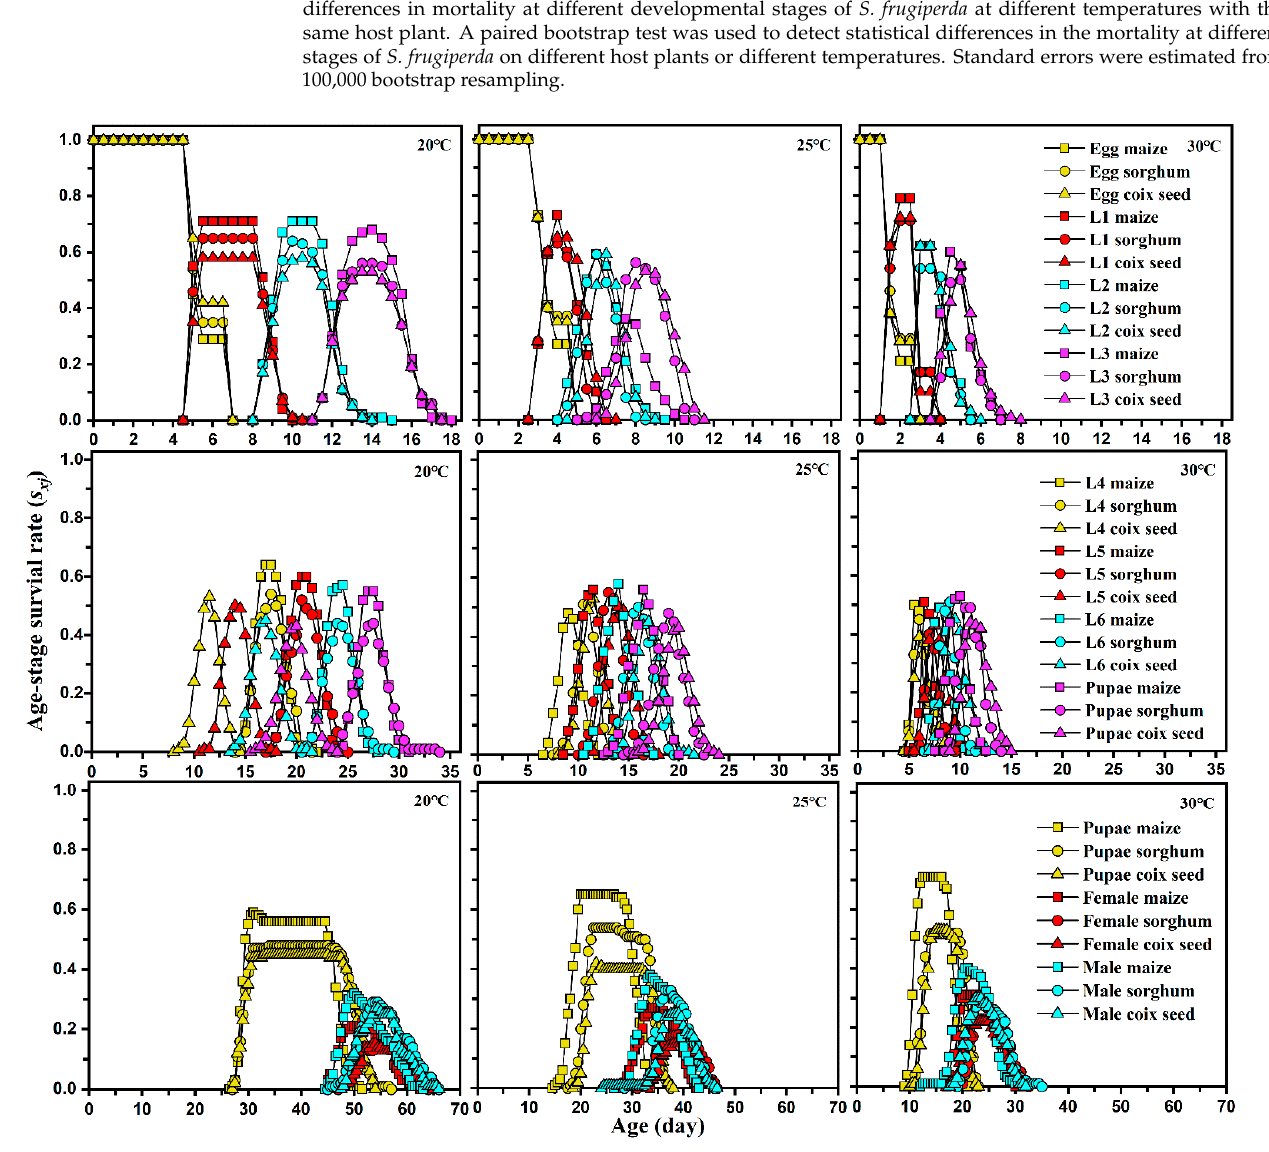
Figure 1. Age-stage specific survival rate ( s xj ) of each developmental stage of Spodoptera frugiperda feeding on different host plants at different temperatures.